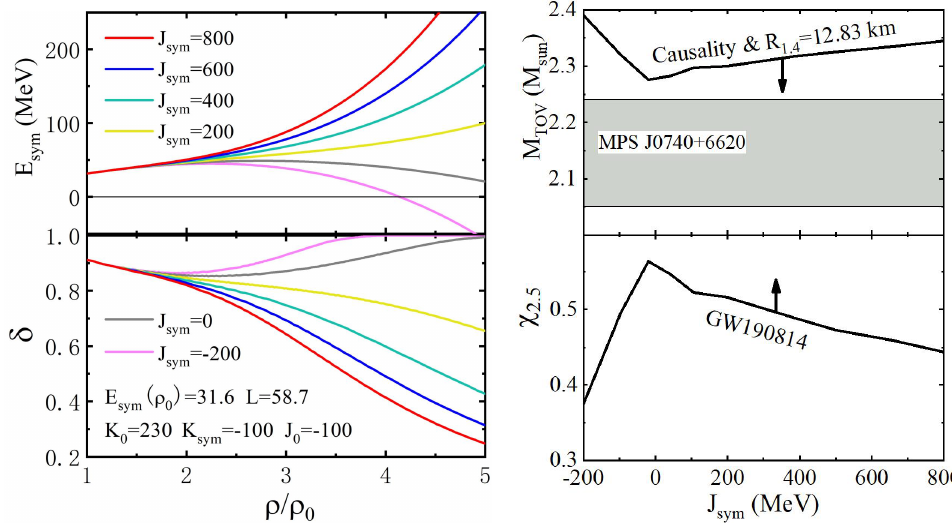
Figure 19. ( Left ) The density dependence of nuclear symmetry energy (upper) and the corresponding isospin asymmetry (lower) in neutron stars at β equilibrium with different skewness J sym parameters. ( Right ) The maximum mass M TOV of non-rotating NSs (upper window) and the minimum spin parameter χ 2.5 of pulsars with the frequency f 2.5 (lower window) as functions of the skewness parameter of nuclear symmetry energy parameter. The previously observed NS maximum mass M = 2.14 + 0.10 − M (cid:12) (68% confidence level) of MSR J0740+6620 is shown in the upper panel. The arrows 0.09 indicate the conditions for GW190814’s secondary to be a superfast pulsar. Taken from